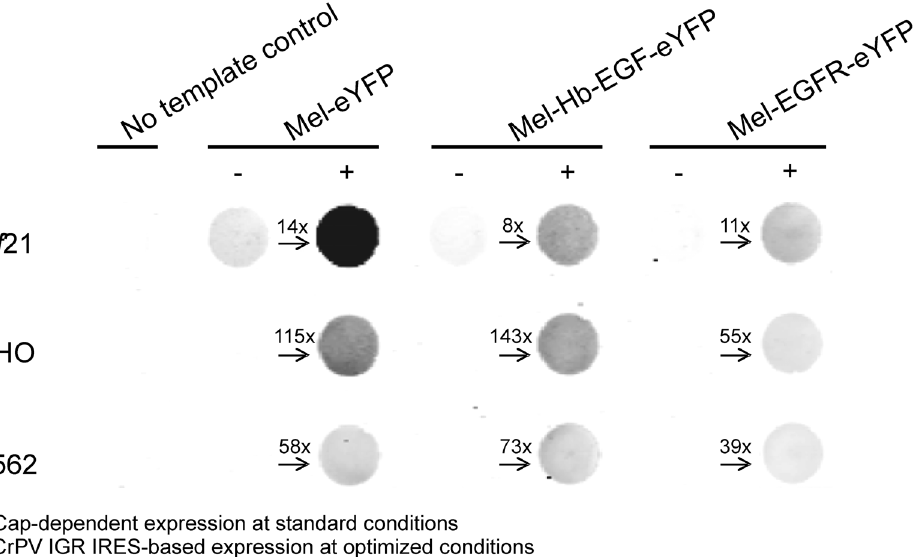
Figure 6. Fluorescence analysis of eYFP-tagged proteins synthesized in coupled Sf 21, CHO and K562 cell-free expression systems. The image depicts the de novo synthesized secreted protein Mel-eYFP as well as the membrane proteins Mel-Hb-EGF-eYFP and Mel-EGFR-eYFP. Plasmids encoding the target proteins were equipped with ( + ) or without ( 2 ) the CrPV IGR IRES (GCU). Numbers indicate the increase of the expression levels using the CrPV IGR IRES-based construct compared to the no IRES control. No template controls were prepared in the same way as the samples, but instead of a DNA template, RNase-free water was added to the reaction. Samples were analyzed using the phosphorimager system (Typhoon TRIO + Imager, GE Healthcare).